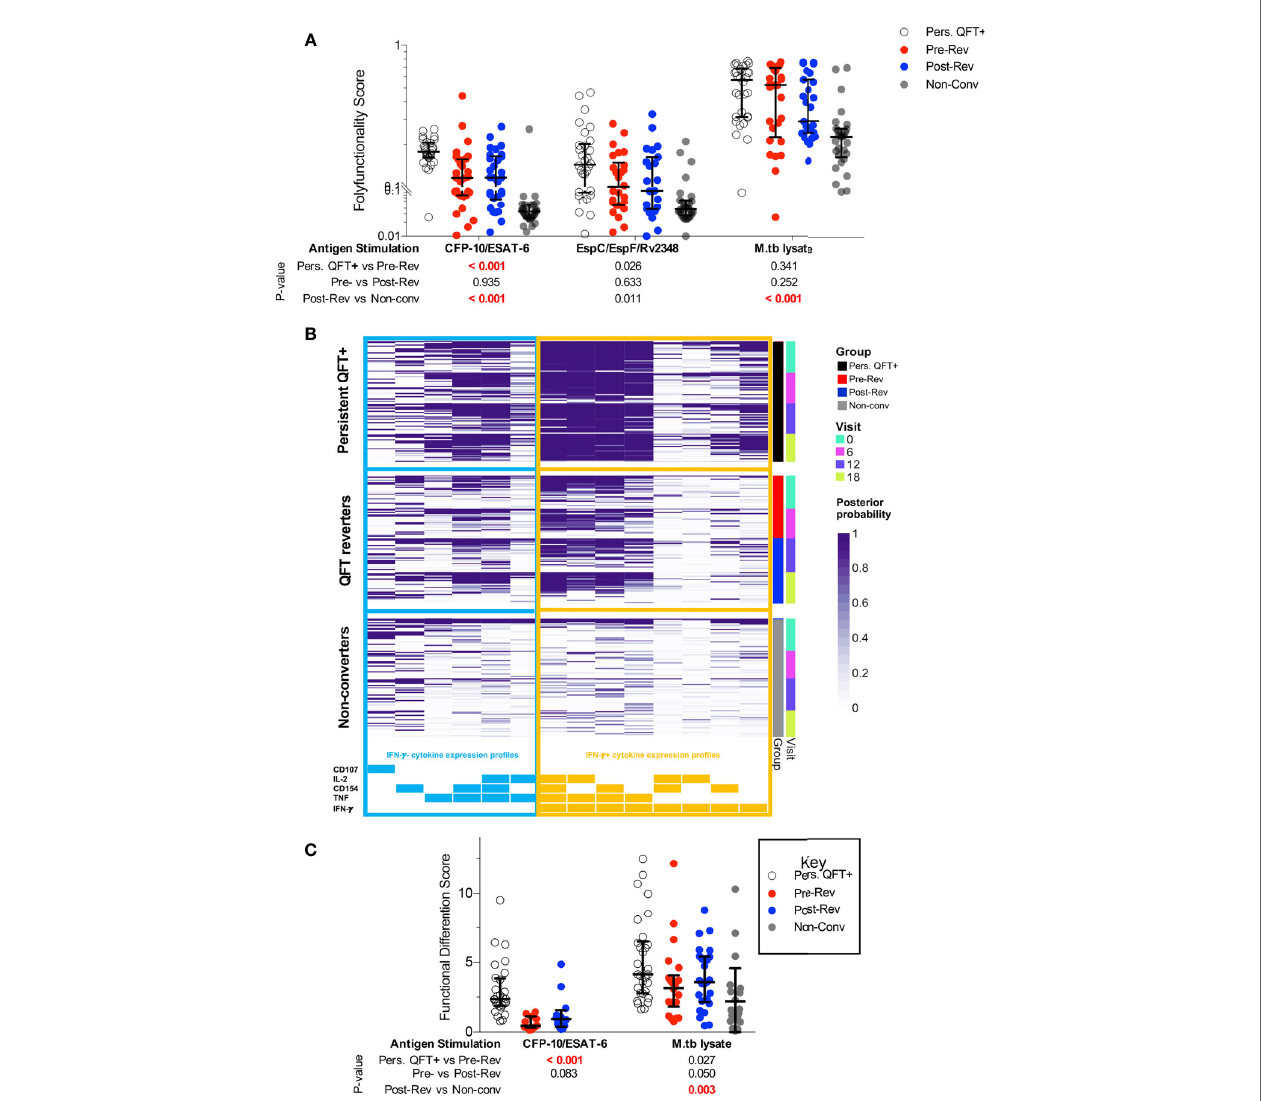
FIGURE 2 | Functional pro fi les of M.tb-speci fi c CD4 T cells are maintained during QFT reversion. (A) CFP-10/ESAT-6-, EspC/EspF/Rv2348- and M.tb lysate- speci fi c polyfunctionality scores calculated by COMPASS. (B) Posterior probabilities (purple shading) of detecting CFP-10/ESAT-6-speci fi c CD4 T cells expressing different combinations of functional markers, as indicated at the bottom. Subsets including IFN- g - cytokine expression pro fi les are grouped on the left (blue) and those including IFN- g + subsets are shown on the right (orange). All participants from all study groups and visits are shown. (C) Functional differentiation score ( Supplementary Equation 1 ) of M.tb-speci fi c CD4 T cells in persistent QFT+ (P10-ES6: n = 28; M.tbL: n = 30), pre-reversion (P10-ES6: n = 11; M.tbL: n = 22), post-reversion (P10-ES6: n = 12; M.tbL: n = 25) and non-converters (M.tbL: n = 24). Number of participants for (A, B) , and calculation of P-values are as in Figure 1 . P-values highlighted in bold red were considered signi fi